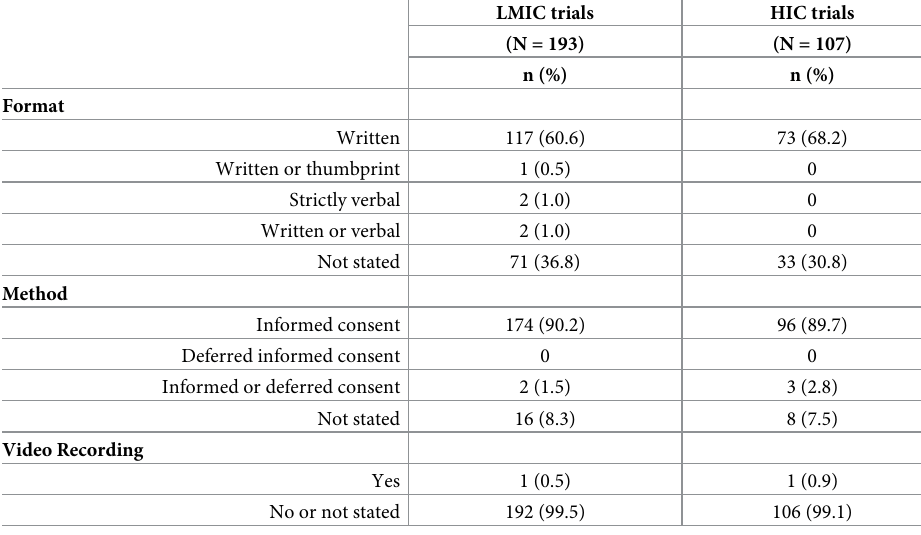
Table 5. Consent process among all included trials in LMICs versus